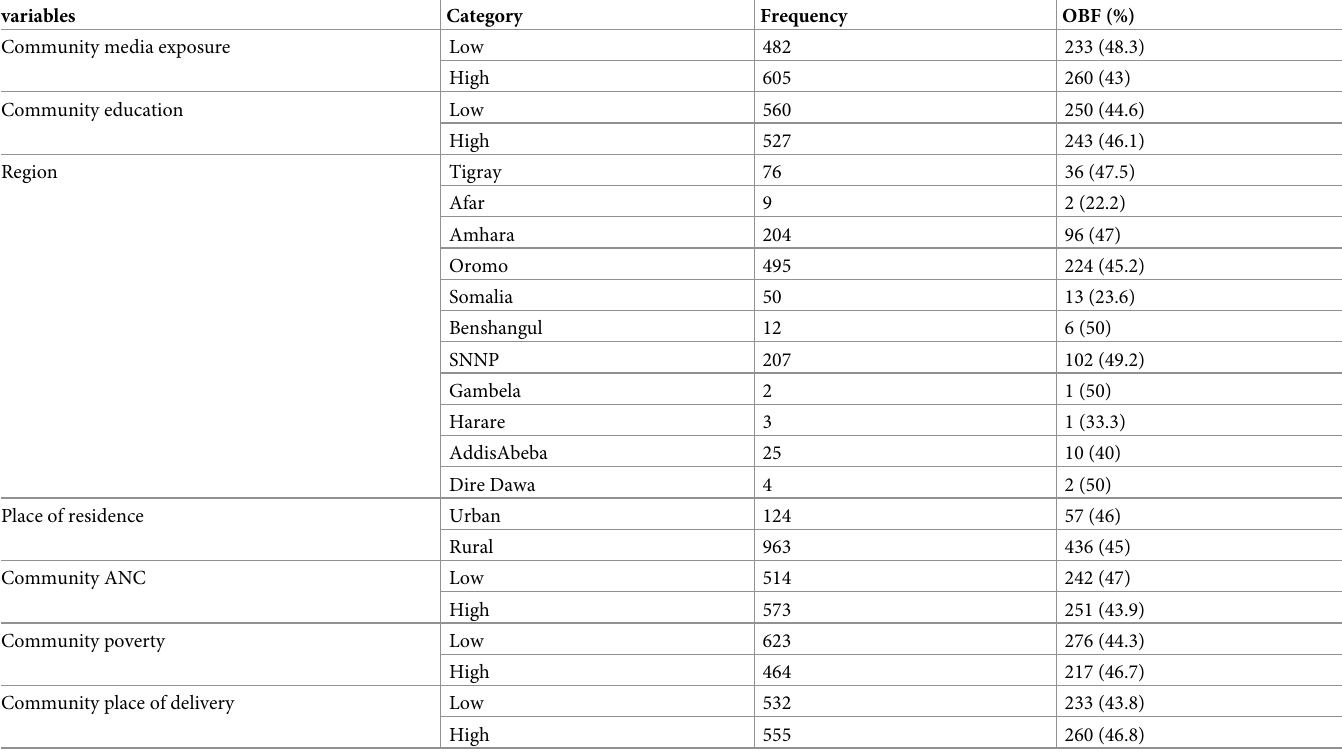
Table 3. Distribution of OBF with community level variables among 0–5 month old children, Ethiopia 2016 (n =